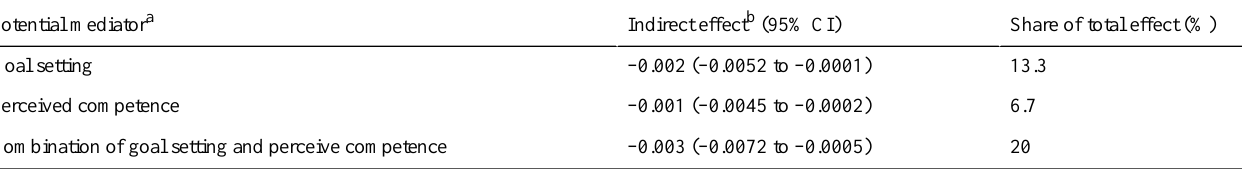
Table 3. Mediating effects of goal setting and perceived competence in the relationship between diabetes distress and hemoglobin A 1c (mediator